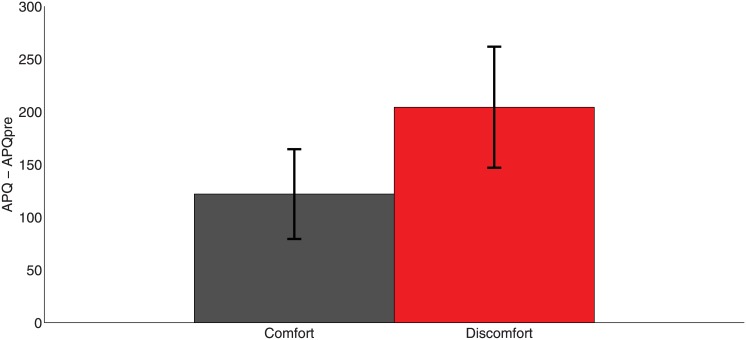
Bar chart of means and standard errors of APQ—APQpre by Condition.